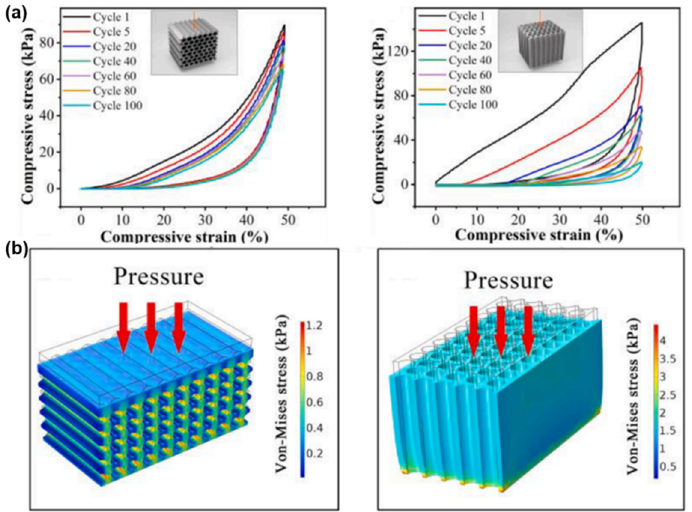
Figure 13. ( a ) Cyclic compressive stress–strain curves and ( b ) finite element analysis of MXene aerogel with aligned honeycomb structure. Reproduced with permission from ref. [145]. Copyright 2021, Elsevier.